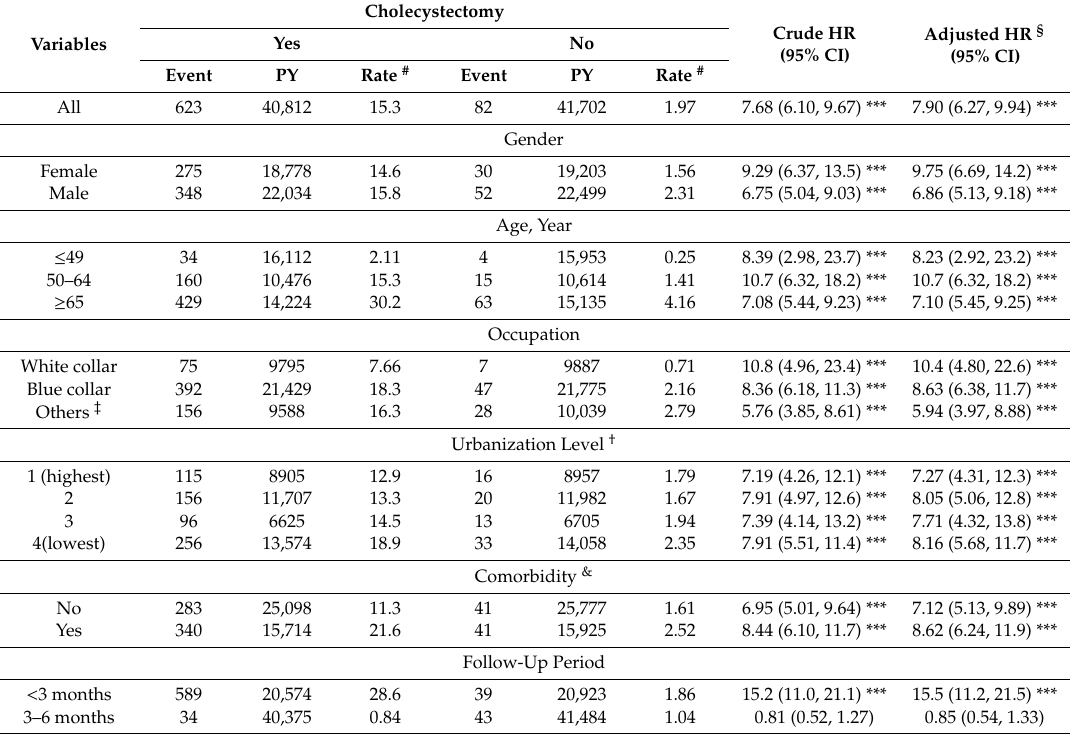
Table 2. The comparison of the colon cancer incidence densities within the first 6 months of the follow-up period between gallbladder stones patients with and without cholecystectomy, based on the stratification of demographic characteristics and the presence or absence of a